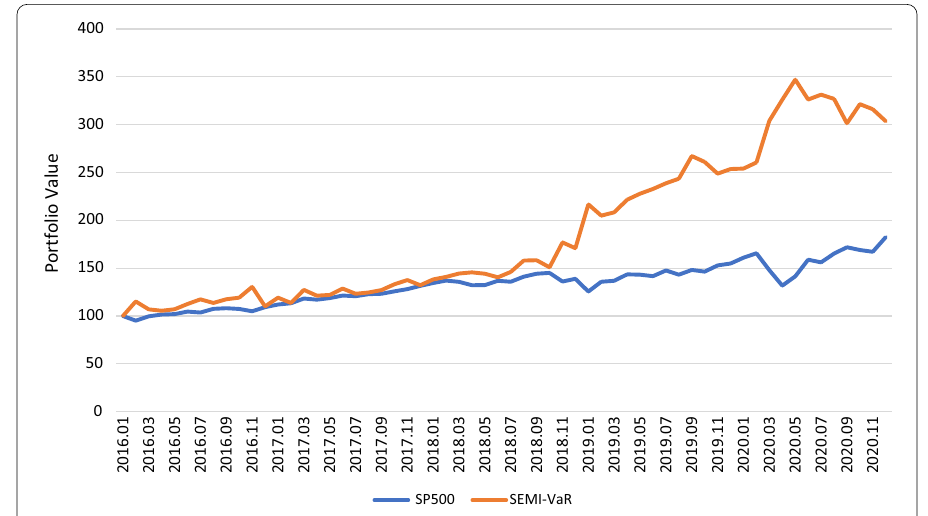
Fig. 1 The portfolio value of the semiparametric model with VaR and S&P 500 from 2016 to 2020. This figure shows the portfolio value of S&P 500 (blue line) and Semiparametric method with VaR ( α = 0.05, yelloline ) in five years (2016 to 2020). The initial value of portfolio is 100. It is clear that the semiparametric method has better performance in return